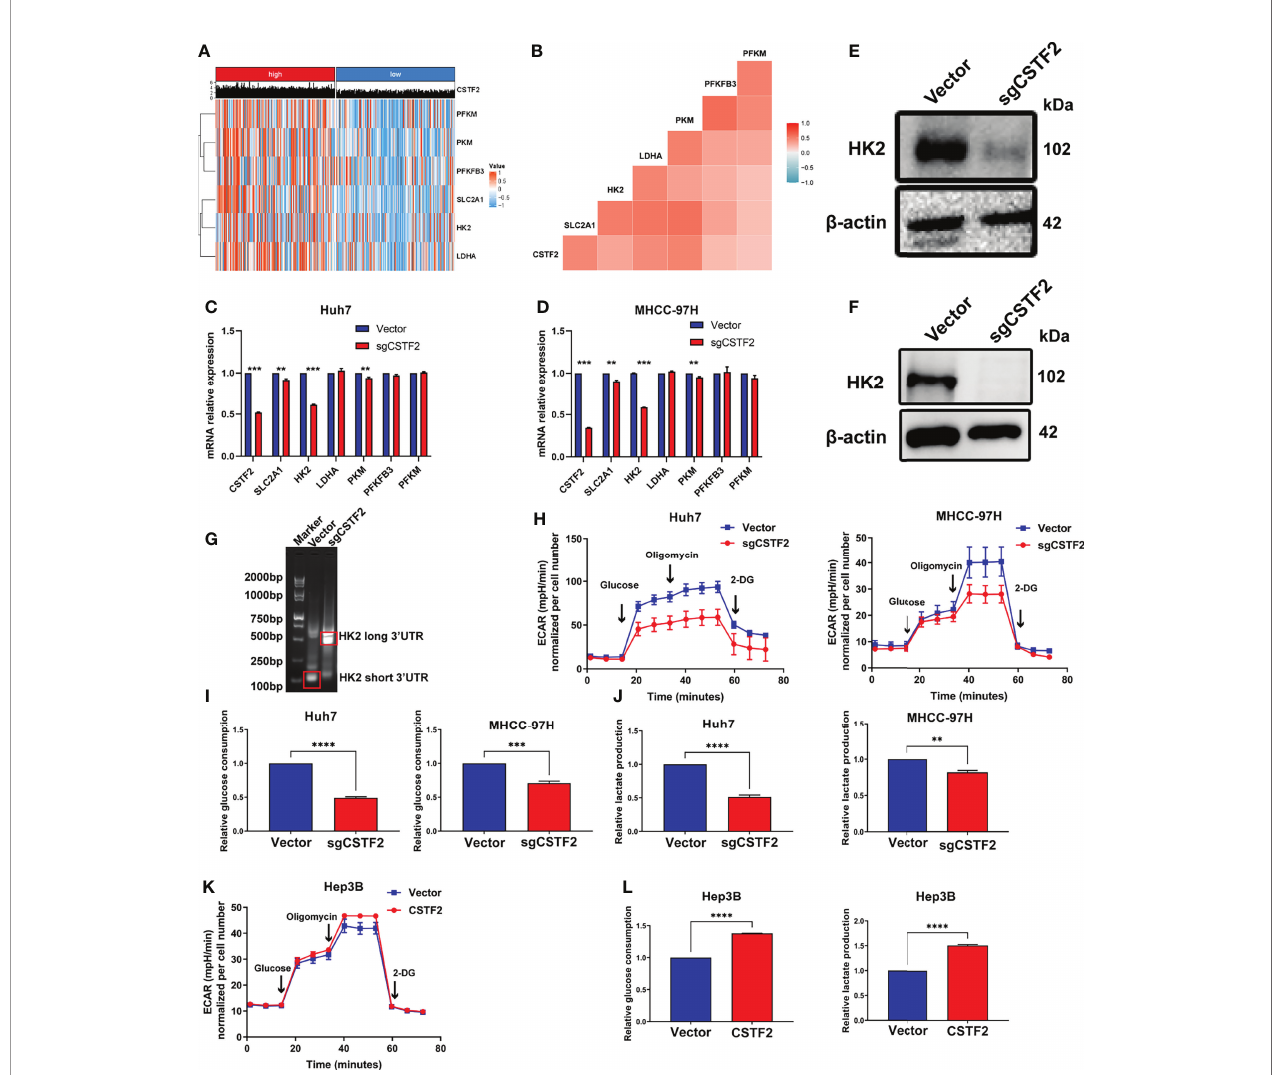
FIGURE 9 | High expression of CSTF2 enhances aerobic glycolysis in HCC. (A) Heat map of the cluster analysis of the relationship between the CSTF2 expression and glycolysis-related enzymes and glucose transporters. (B) The correlation analysis of CSTF2 expression and glycolysis-related enzymes and glucose transporters. (C-D) The relative expression levels of CSTF2, SLC2A1, HK2, LDHA, PKM, PFKFB3, and PFKM detected by quantitative RT-PCR in Huh7 cells and MHCC-97H cells. (E – F) The protein levels of HK2 in Huh7 cells and MHCC-97H cells determined by Western blot; the levels of b -actin were used as an internal control. (G) 3 ’ RACE HK2 fragments were ampli fi ed in Huh7 cells and detected by agarose gel electrophoresis. (H – J) The glycolytic function of HCC cells was measured by the extracellular acidi fi cation rate (EACR), relative glucose uptake, and lactate production in CSTF2 knockout Huh7 and MHCC-97H cells. (K-L) The glycolytic function of HCC cells was measured by EACR, the relative glucose uptake, and lactate production in CSTF2-overexpression Hep3B cells. sgCSTF2 represents CSTF2 sgRNA, CSTF2 represents CSTF2 overexpression, and the vector was used as control. Data were presented as the mean ± SEM. ** r < 0.01, *** r < 0.001 compared to the